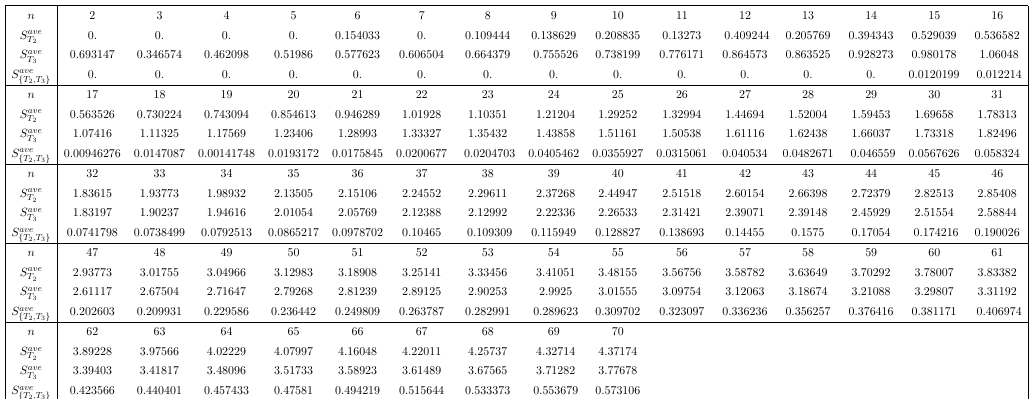
Table 2 . Table showing the average entropy values S ave